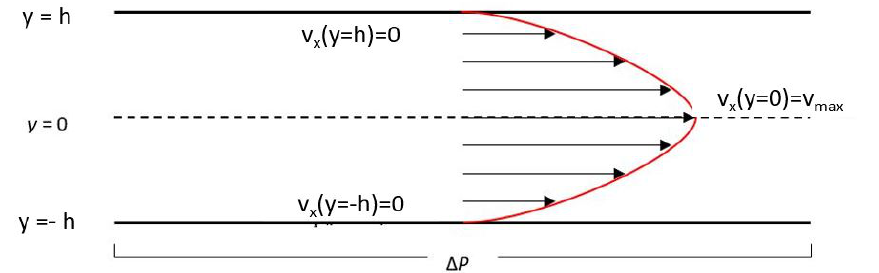
Figure 2. A schematic diagram of Poiseuille profile for a 2D channel flow system. In 3D, a surface plane is